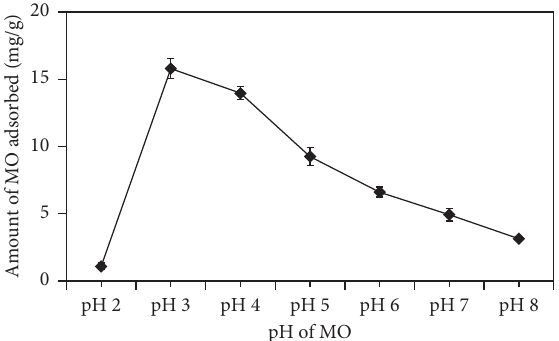
Figure 5: Effects of pH on the adsorption of MO using cross-linked chitosan beads. The bead crosslinkers are ECH 5% immersed in TPP 10% for 12h; sample: 50mL methyl orange 20ppm; cross-linked chitosan bead’s mass: 0.02g; and stirring rate � 100rpm.